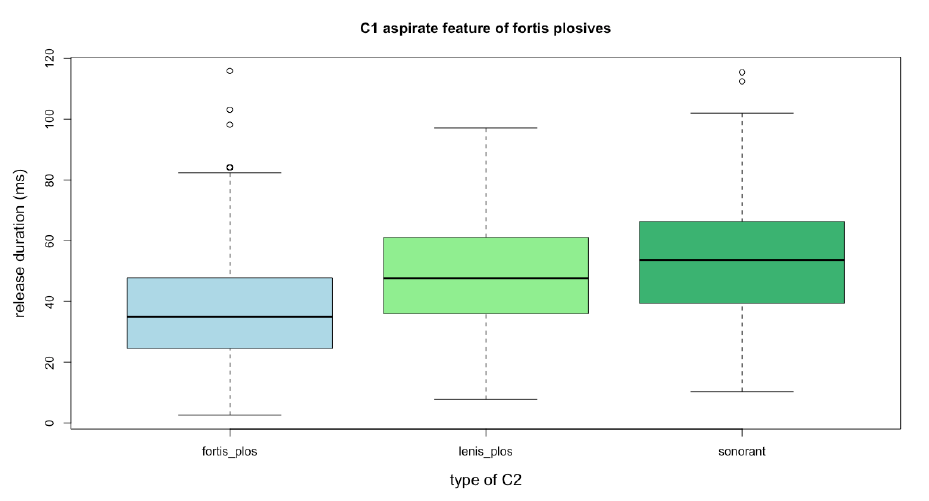
Figure 3: Effects of C₂ type on C₁ fortis plosive release